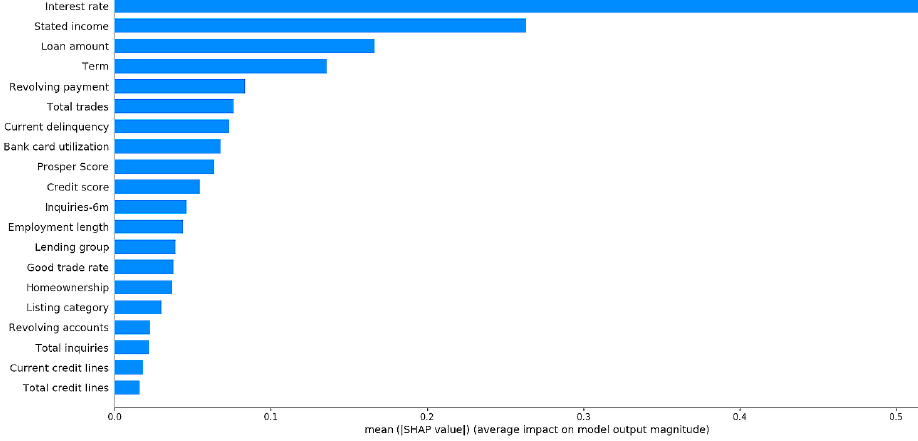
Figure 5. 5-fold cross-validation SHAP feature importance of XGBoost under Prosper dataset. The SHAP feature importance is measured by average absolute Shapley values and visualized in descending